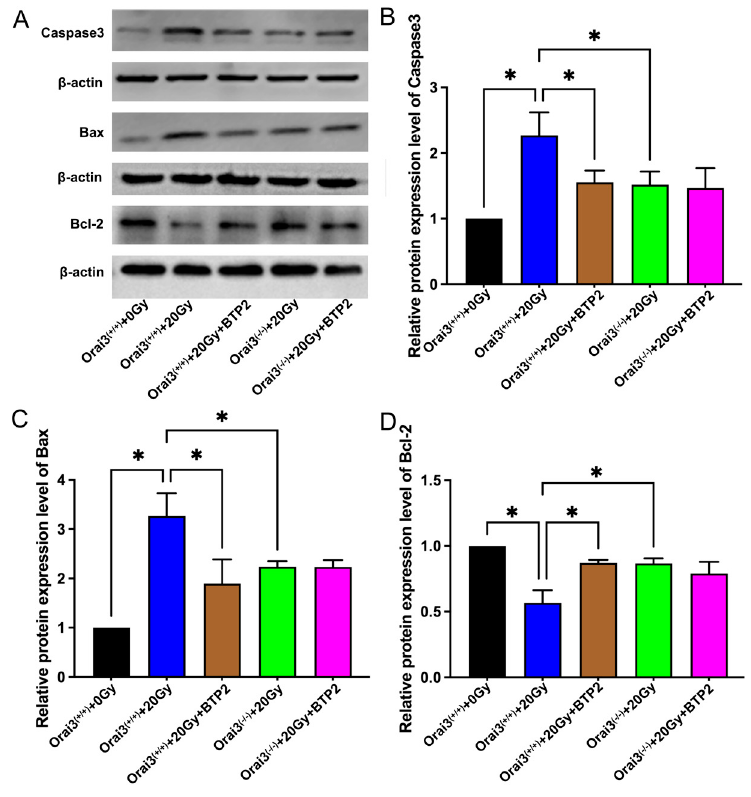
Figure 7. Role of Orai3 in X ‒ ray irradiation-induced changes in expression levels of apoptosis-related proteins in rat brain microvascular endothelial cells (rBMECs). ( A – D ) Representative images ( A ) and summary data ( B – D ) showing caspase3, Bax, and Bcl-2 protein expression levels in rBMECs derived from wild-type (Orai3 (+/+) ) rats unexposed (0 Gy) or exposed to X-ray irradiation (20 Gy) and untreated or treated with BTP2 (5 µM); and from Orai3 knockout rats (Orai3 (+/+) ) exposed to X ‒ ray irradiation (20 Gy) and untreated or treated with BTP2 (5 µM). Data are shown as the mean ± SEM ( n = 3), * p < 0.05 analyzed by one ‒ way analysis of variance followed by Dunne tt ’s multiple comparisons test.